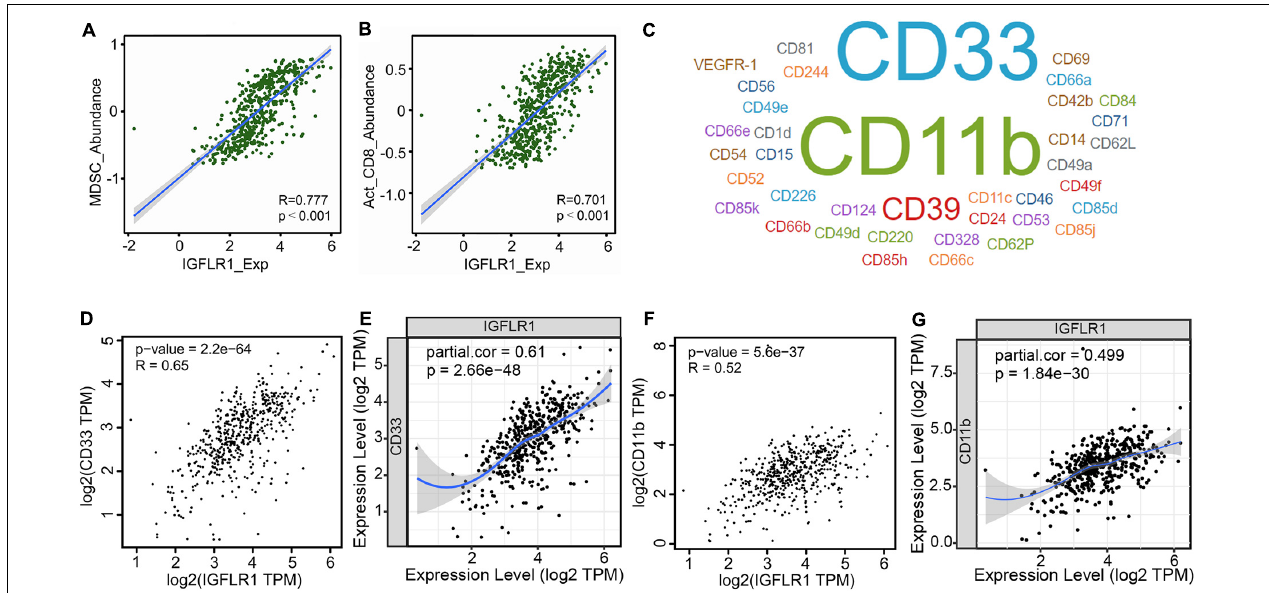
FIGURE 5 | Correlation analysis between IGFLR1 expression and TIICs and its immune marker sets. (A,B) The correlation between IGFLR1 expression and the abundance of MDSC and activated CD8+ T cell in ccRCC based on TISIDB. (C) The marker genes of MDSC according to CellMarker, and the font size represented the amount of evidence supporting. (D,F) Correlation between IGFLR1 expression and CD33 and CD11b using TISIDB. (E,G) Correlation between IGFLR1 expression and CD33 and CD11b using TIMER. The partial correlation was conditioned on tumor